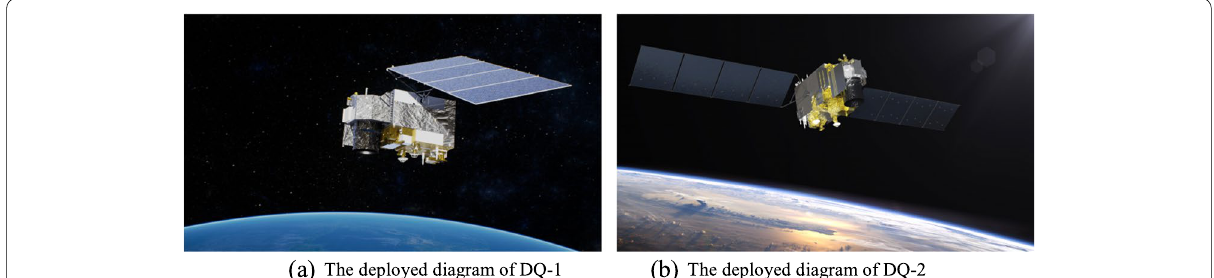
Fig. 8 Artist’s rendition of deployed DQ-1 and DQ-2. a The deployed diagram of DQ-1. b The deployed diagram of